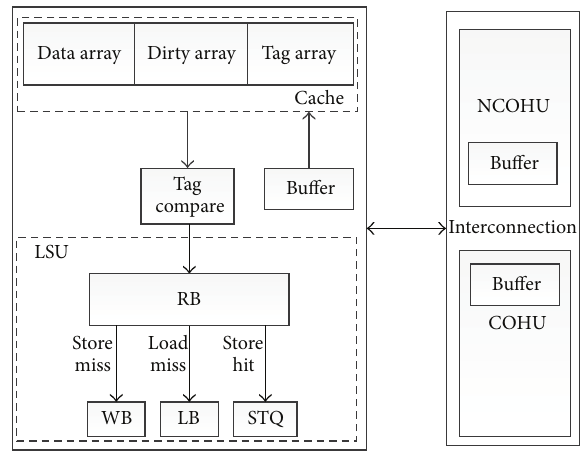
Figure 3: Block diagram of hardware. RB is used to preserve load/store transactions and maintain their order. WB keeps store misstransactions,LBisresponsibleforpreservingloadmisstransac- tions, and STQ keeps store hit transactions. COHU maintains cache coherence between cores and NCOHU deals with the transactions unrelated to cache